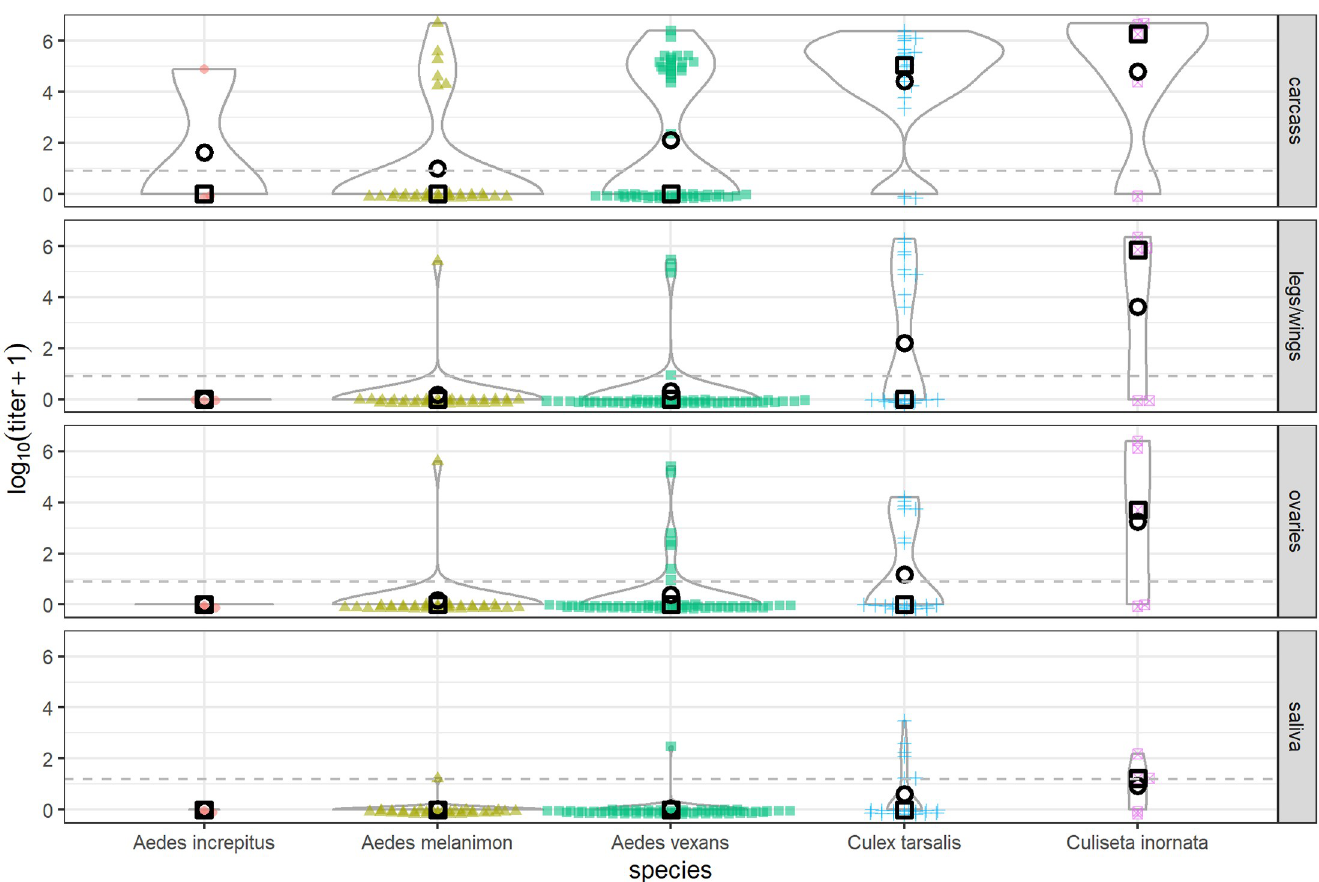
Fig 2. PFU/mL RVFV detected in mosquito tissues by plaque assay. Dashed lines represent limits of detection for the assay. Mean values are shown as open black circles, while median values are shown as open squares. Violin densities show distributions of the data (solid gray